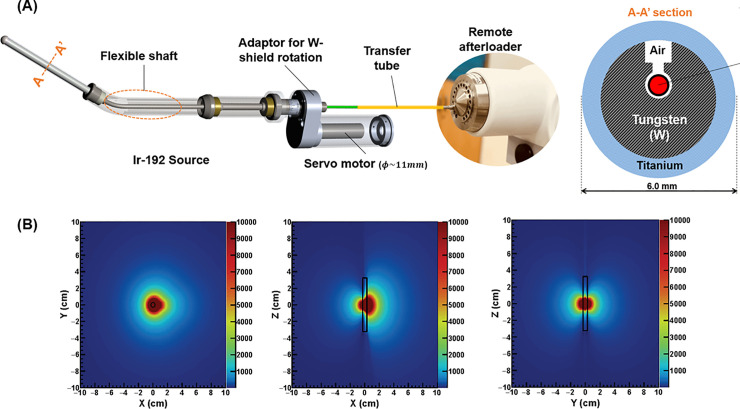
Novel rotatable tandem applicator and estimated dose distribution.(A) Novel, rotatable tandem applicator. (Bottom) Monte-Carlo-simulated dose distribution in water medium for 192Ir radiation source with the new tandem applicator, which is orthogonal to the axial plane, irradiated to the left-hand side in the image plane.